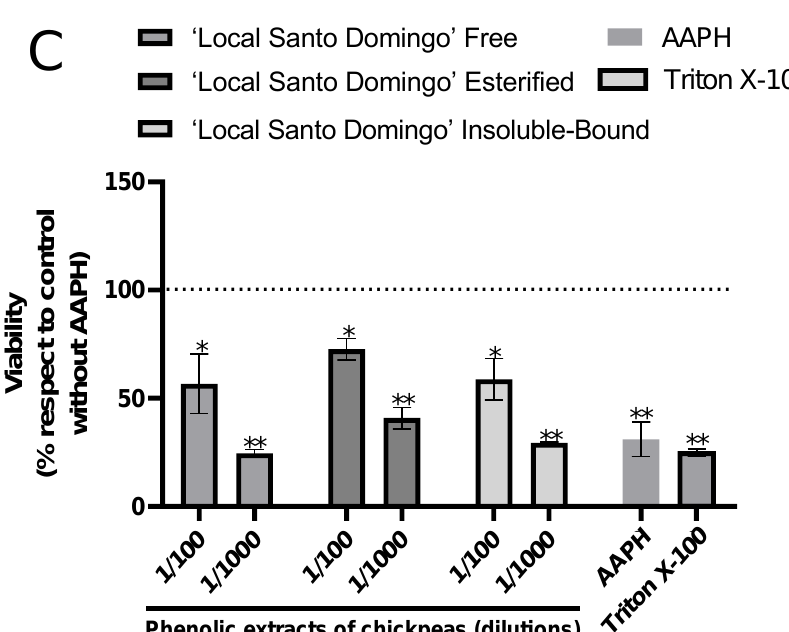
Figure 3. Phenolic extracts of chickpeas prevents AAPH-induced cell death. Cell viability evaluated by Alamar blue of HUH-7 cells treated with phenolic extracts of chickpeas of ‘Alfa-INIA’ ( A ), ‘Local Navidad’ ( B ) and ‘Local Santo Domingo’ ( C ) at different dilutions (1/100, 1/1000 or 1/10,000) and co-treatment with 2,2 (cid:48) -Azobis (2-amidinopropane) dihydrochloride (AAPH) for 24 h at 200 mM. Positive control of cell death, cells treated with Triton X-100 at 1% for 10 min. Data are expressed as percentage of viability with respect to the control cells (Cells without AAPH). Data are shown as mean ± SD (n = 3). A one-way ANOVA statistical test was performed followed by Tukey test. Statistically significant differences compared to the control group (cells without treatment) (* p < 0.05, ** p < 0.01).